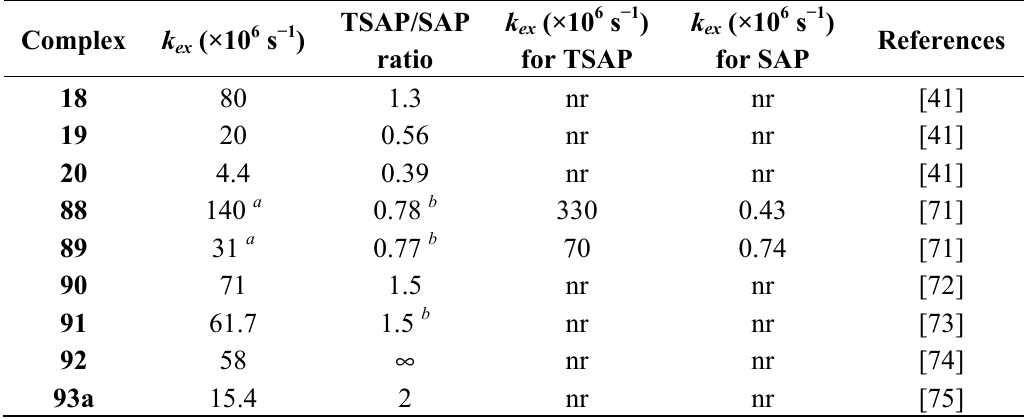
Table 6. Water-exchange rates and TSAP/SAP ratios of Gd III -containing complexes ( 18 – 20 and 88 – 97 ) discussed in Section